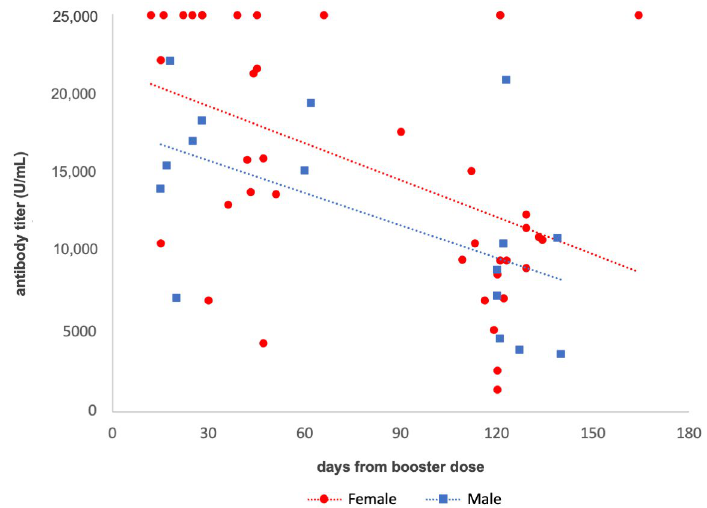
Figure 3. Scatter diagram showing the antibody titer (detection limits 0.4–25,000 U/mL) after the booster dose of female and male subjects against time and related regression lines.